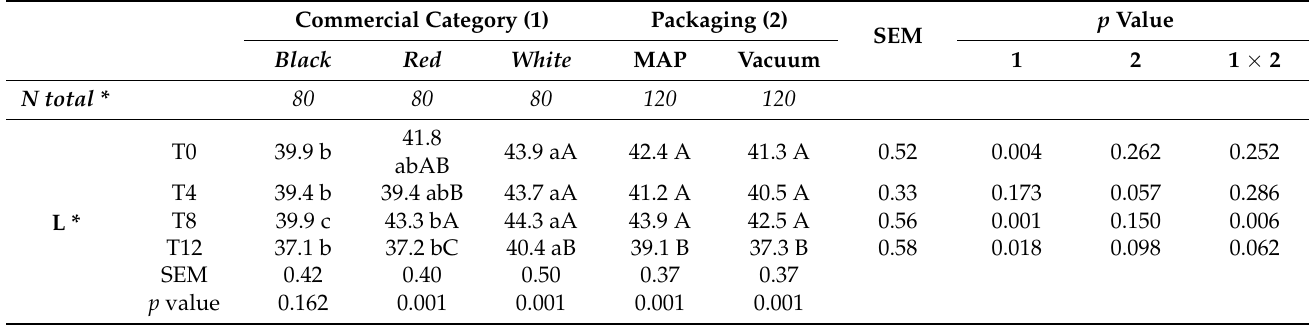
Table 2. Instrumental colour changes of sliced Iberian dry-cured ham from different commercial categories and with different packaging conditions for 12 months of refrigeration